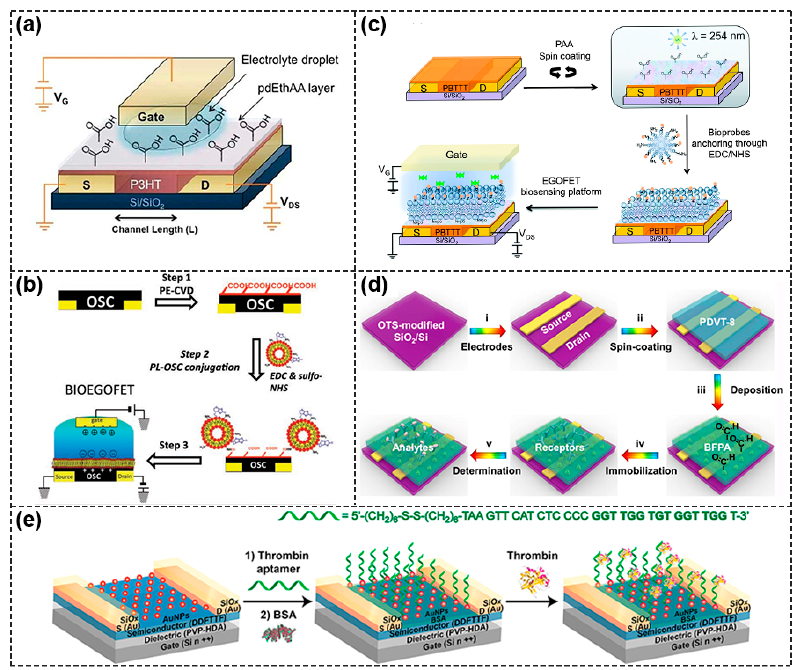
Figure 4. Schematic diagram of physical functionalization methods. ( a ) Schematic of a functional layer containing carboxyl groups deposited on the surface of P3HT semiconductor. Reproduced with permission from [24]. Copyright 2013, WILEY − VCH Verlag GmbH & Co. KGaA, Weinheim. ( b ) Procedure of the PECVD method to introduce carboxyl functional layer onto the OSC surface and immobilization of phospholipid (PL) molecule for biological modification. Reproduced with permission from [25]. Copyright 2013, John Wiley and Sons. ( c ) Schematic diagram of introducing the carboxyl functional layer onto PBTTT surface, including the spin coating of PAA layer on PBTTT surface and subsequent UV − assisted cross − linking process. Reproduced with permission from [26]. Copyright 2015, Royal Society of Chemistry ( d ) Schematic diagram of BFPA layer pre- pared by spin − coating method as both protective layer and functional layer. Reproduced with permission from [27]. Copyright 2021, American Chemical Society. ( e ) Schematic of using deposited gold nanoparticles (AuNPs) on DDFTTF semiconductor surfaces as functional layers to provide binding sites for DNA aptamer. Reproduced with permission from [30]. Copyright 2013, American Chemical Society. 2.2.2. Chemical Functionalization Methods One of the chemical functionalization methods is to introduce functional groups directly to semiconductors that have outstanding charge transport properties so that bi- ological receptors can be immobilized onto them. Horowitz’s group synthesized a new biotinylated polymer semiconductor consisting of biotin groups to detect avidin and streptavidin (Figure 5a) [31]. However, due to the introduction of functional groups, the molecular packing was changed and weakened π − π interaction among the molecules, which affected the transport path of charges and led to a sharp deterioration in device performance[32]. There were also some researchers using techniques such as ultraviolet (UV)ozone treatment and O 2 plasma treatment to generate a small number of defects on the semiconductor surface to serve as binding sites for biological receptors. For example, Zhu’s group used the method of plasma − assisted − interface − grafting to introduce molec- ular antennas on the surface of semiconductors (Figure 5b). Minimized molecular gaps and reduced boundary interactions enhanced the interaction between the semiconductor